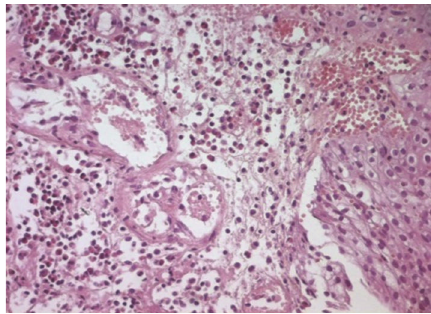
Figure 2: H.E. × 250 vascular congestion of the urothelial mu- cosae with an inflammatory infiltrate consisting predominantly of eosinophils, suggesting eosinophilic